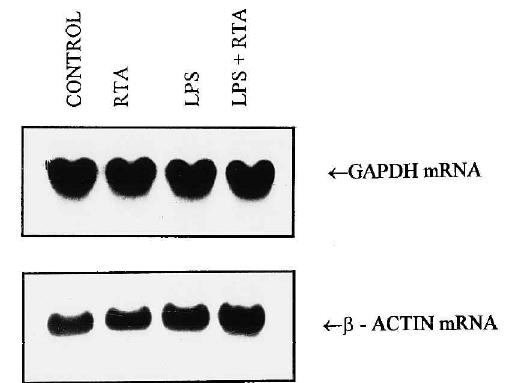
FIG. 4. Abundance of GAPDH mRNA and b -actin mRNA in PMA-primed U937 cells cultured for 18h with RTA (10 m M) and/or LPS